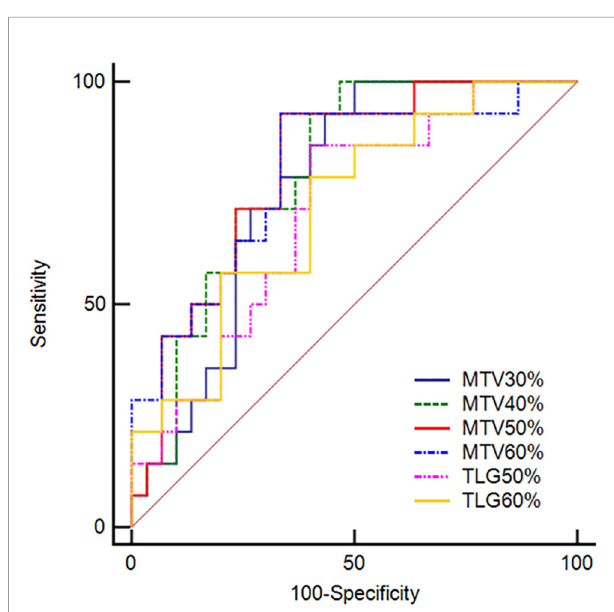
FIGURE 5 | Receiver operating characteristic curves of MTV 30% , MTV 40% , MTV 50% , and MTV 60% as well as TLG 50% and TLG 60% derived from PET/CT images for predicting MSI in CRC patients. The AUCs for predicting MSI from MSS were 0.764, 0.795, 0.805, and 0.795 for MTV 30% , MTV 40% , MTV 50% , and MTV 60% , respectively. In addition, the AUCs were 0.707 and 0.717 for TLG 50% and TLG 60%